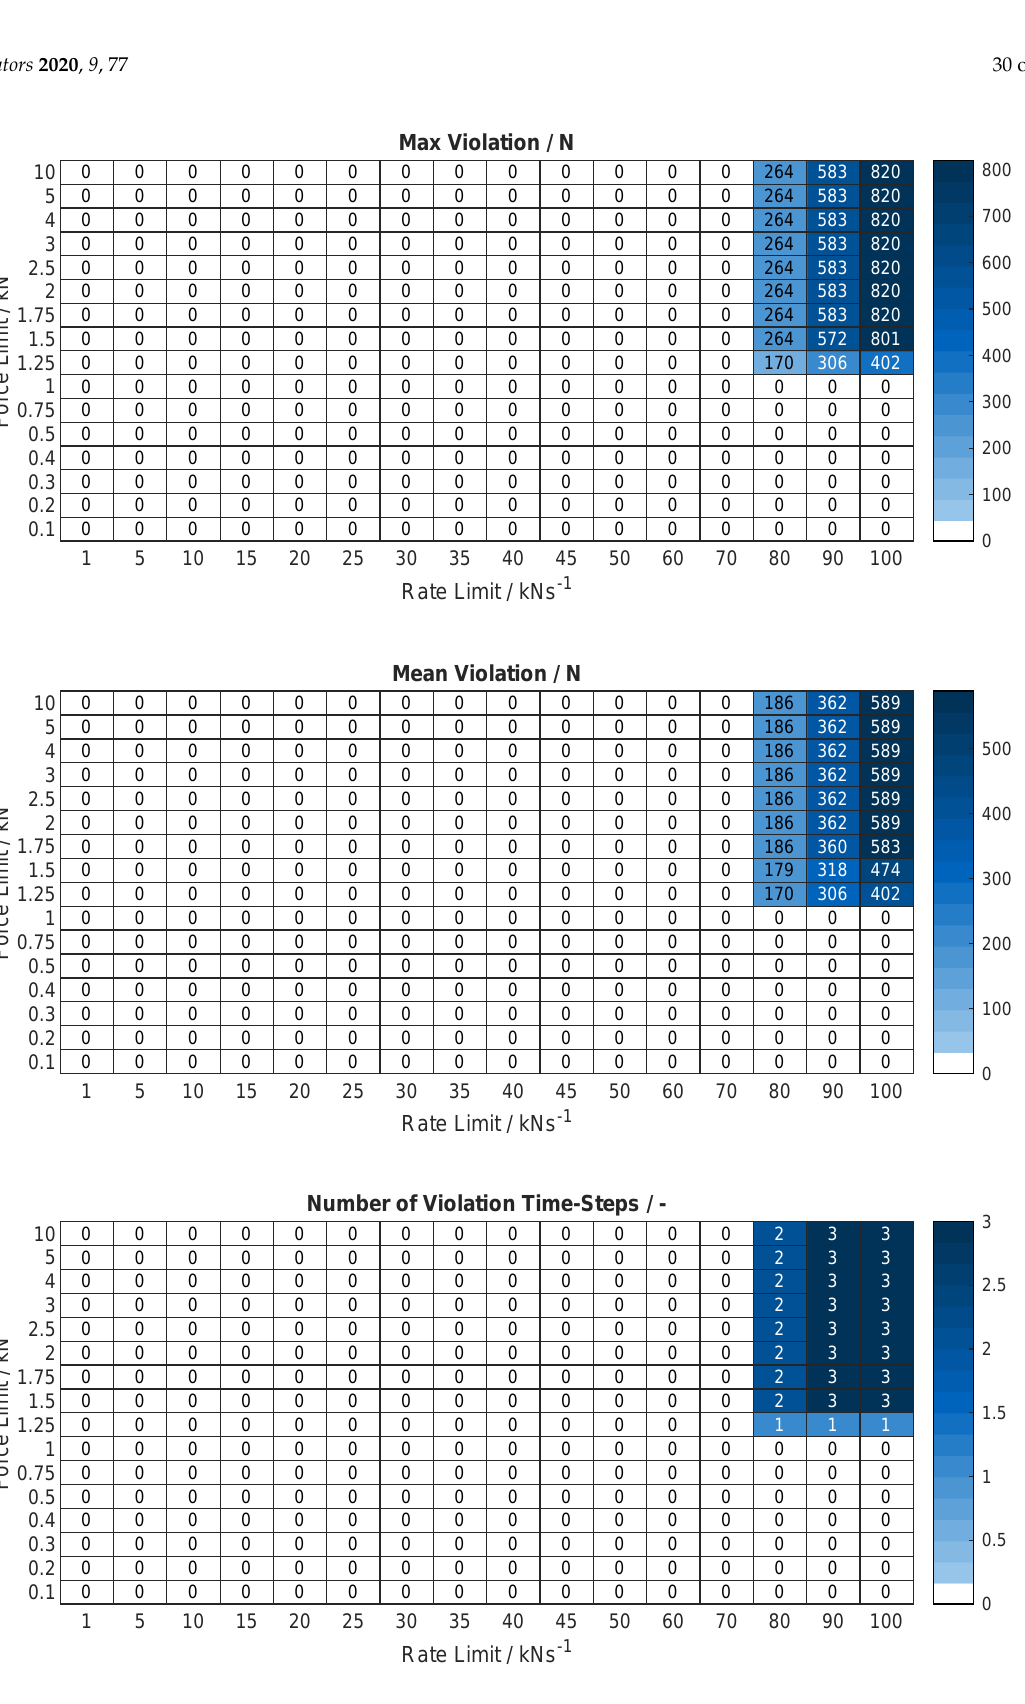
Figure A15. Dynamic wheel-load constraint violations in the 90kmh − 1 AB profile